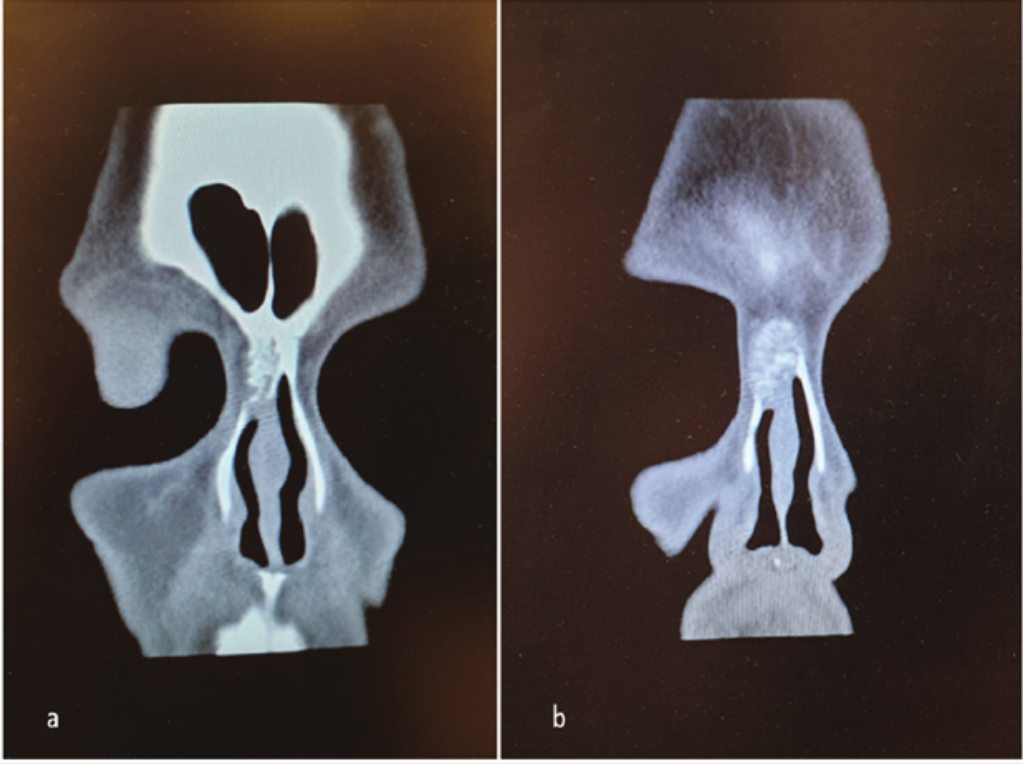
Figure 1 : Computerized tomography (CT) of paranasal sinus showing an expansile destructive trabeculated bony lesion with a soft tissue component centered on the right nasal bone inseparable from the underlying cartilaginous nasal septum with its deviation to